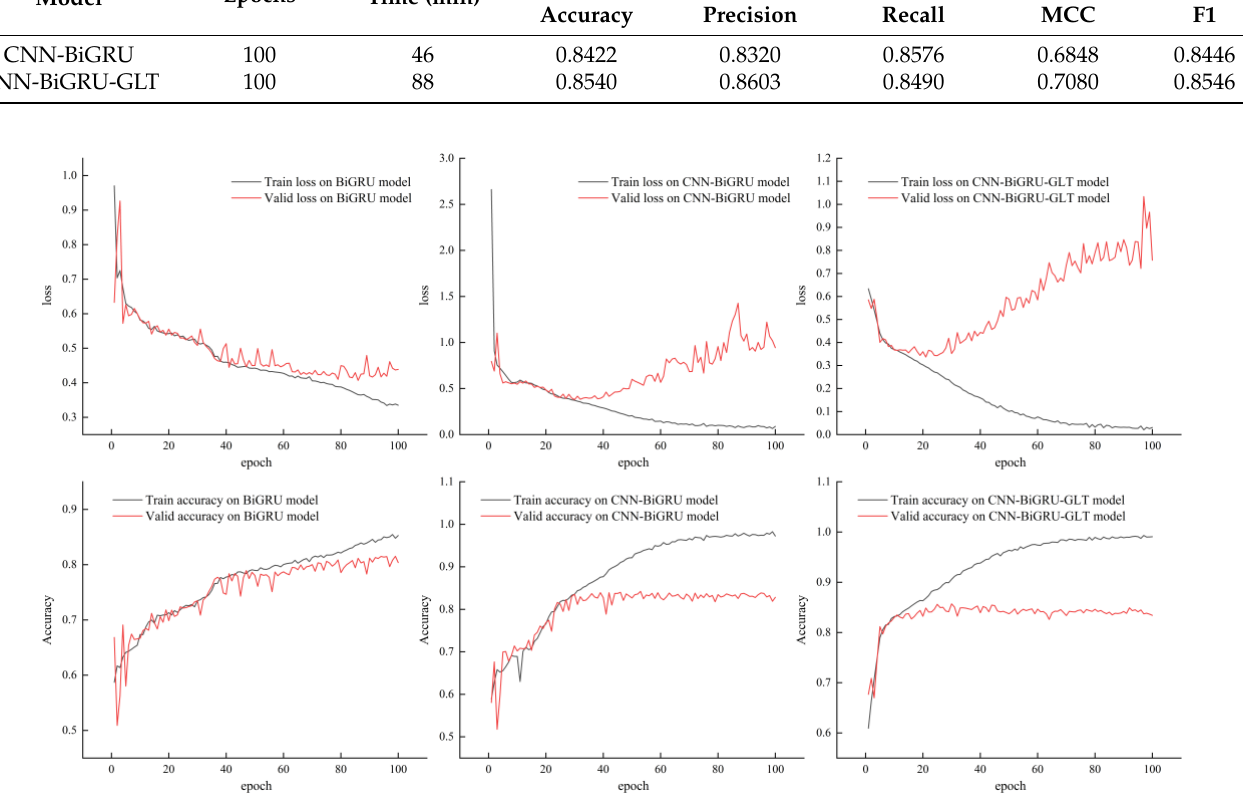
Figure 4. Loss and accuracy variation in each epoch for training and validation sets on different models with various degrees of improvement (BiGRU, CNN-BiGRU, and